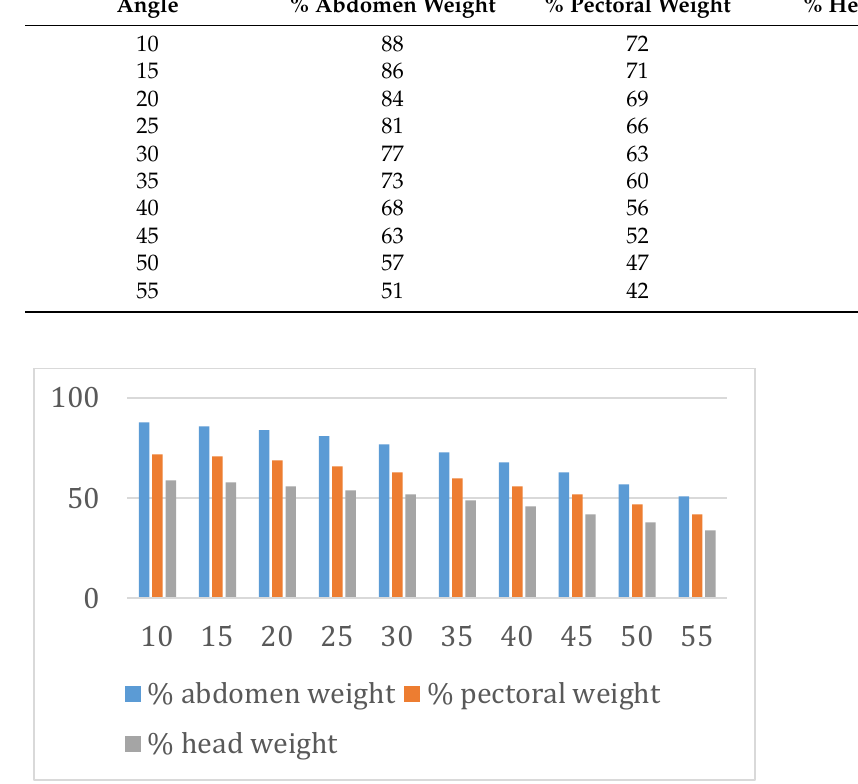
Figure 4. Percentage of load depending on the angle and height of the grip. Table 1. Weight distribution according to working angles and grip positions. Data are for the same subject of mass 60 kg and 1.60 m in height, and expressed as the percentage of body weight mobi- lized in each repetition.